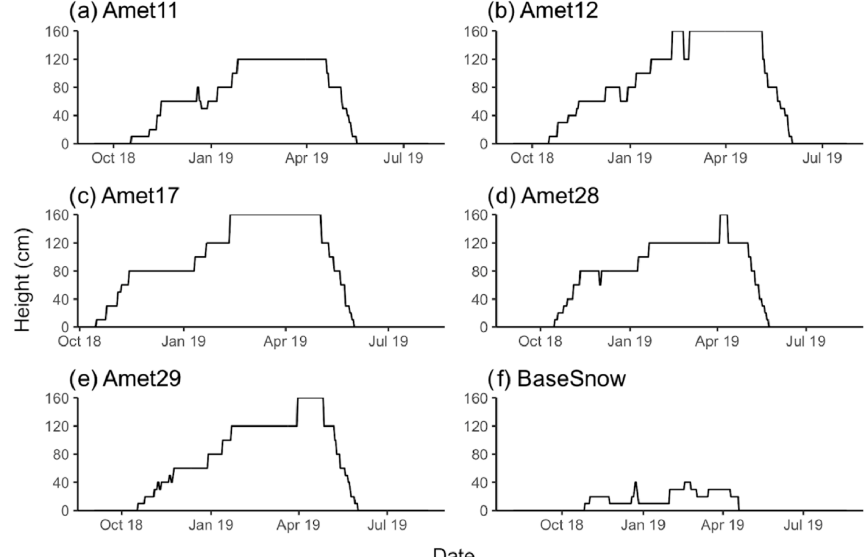
Figure 6. Snow depth over 2018–2019 derived using change-point analysis of raw lux values from loggers at each SCLT measurement site including (a) Amet11, (b) Amet12, (c) Amet17, (d) Amet28, (e) Amet29 and (f) BaseSnow. Top logger positions ranged from 120cm (Amet11 and BaseSnow) to 160cm (Amet12, Amet17, Amet28, Amet29) and cannot detect snow depths above this height.